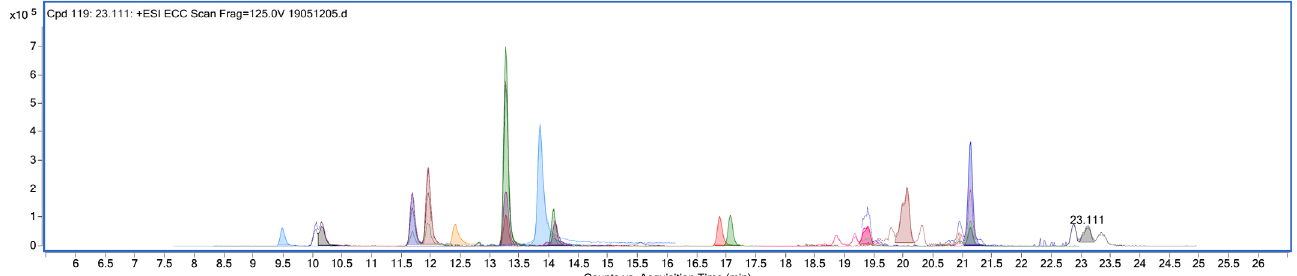
masses calculated for each of the compounds.